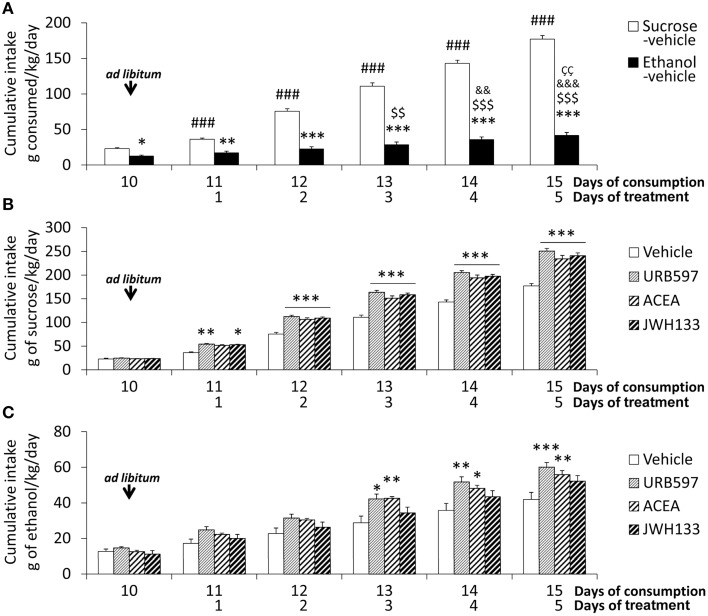
Effects of the repeated administration of URB597 (0.3 mg/kg), ACEA (3 mg/kg), and JWH133 (0.2 mg/kg) on the cumulative ad libitum consumption of sucrose and ethanol. (A) Compared consumption of sucrose and ethanol. (B) Treatment effects on sucrose consumption. (C) Treatment effects on ethanol consumption. The histograms represents the mean + s.e.m. (n = 6) per experimental group. Bonferroni's test following repeated measures ANOVA: ###P < 0.001 vs. the backward time points; $$∕$$$P < 0.01/0.001 vs. day 10; &&∕&&&P < 0.01/0.001 vs. day 11; P < 0.01 vs. day 12. Bonferroni's test following two-way ANOVA: *P < 0.05, **P < 0.01, ***P < 0.001 vs. the sucrose-vehicle or ethanol-vehicle groups at the same time point.